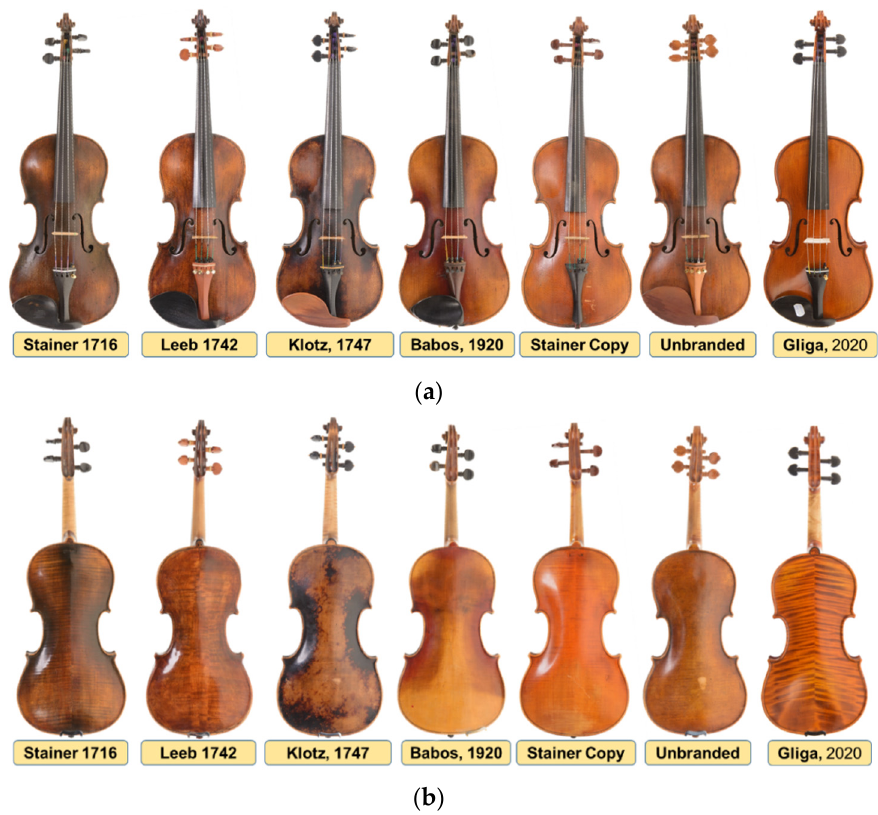
Figure 3. Old violins analyzed using non-invasive and non-destructive methods: ( a ) front view of studied violins; ( b ) back view of violins.